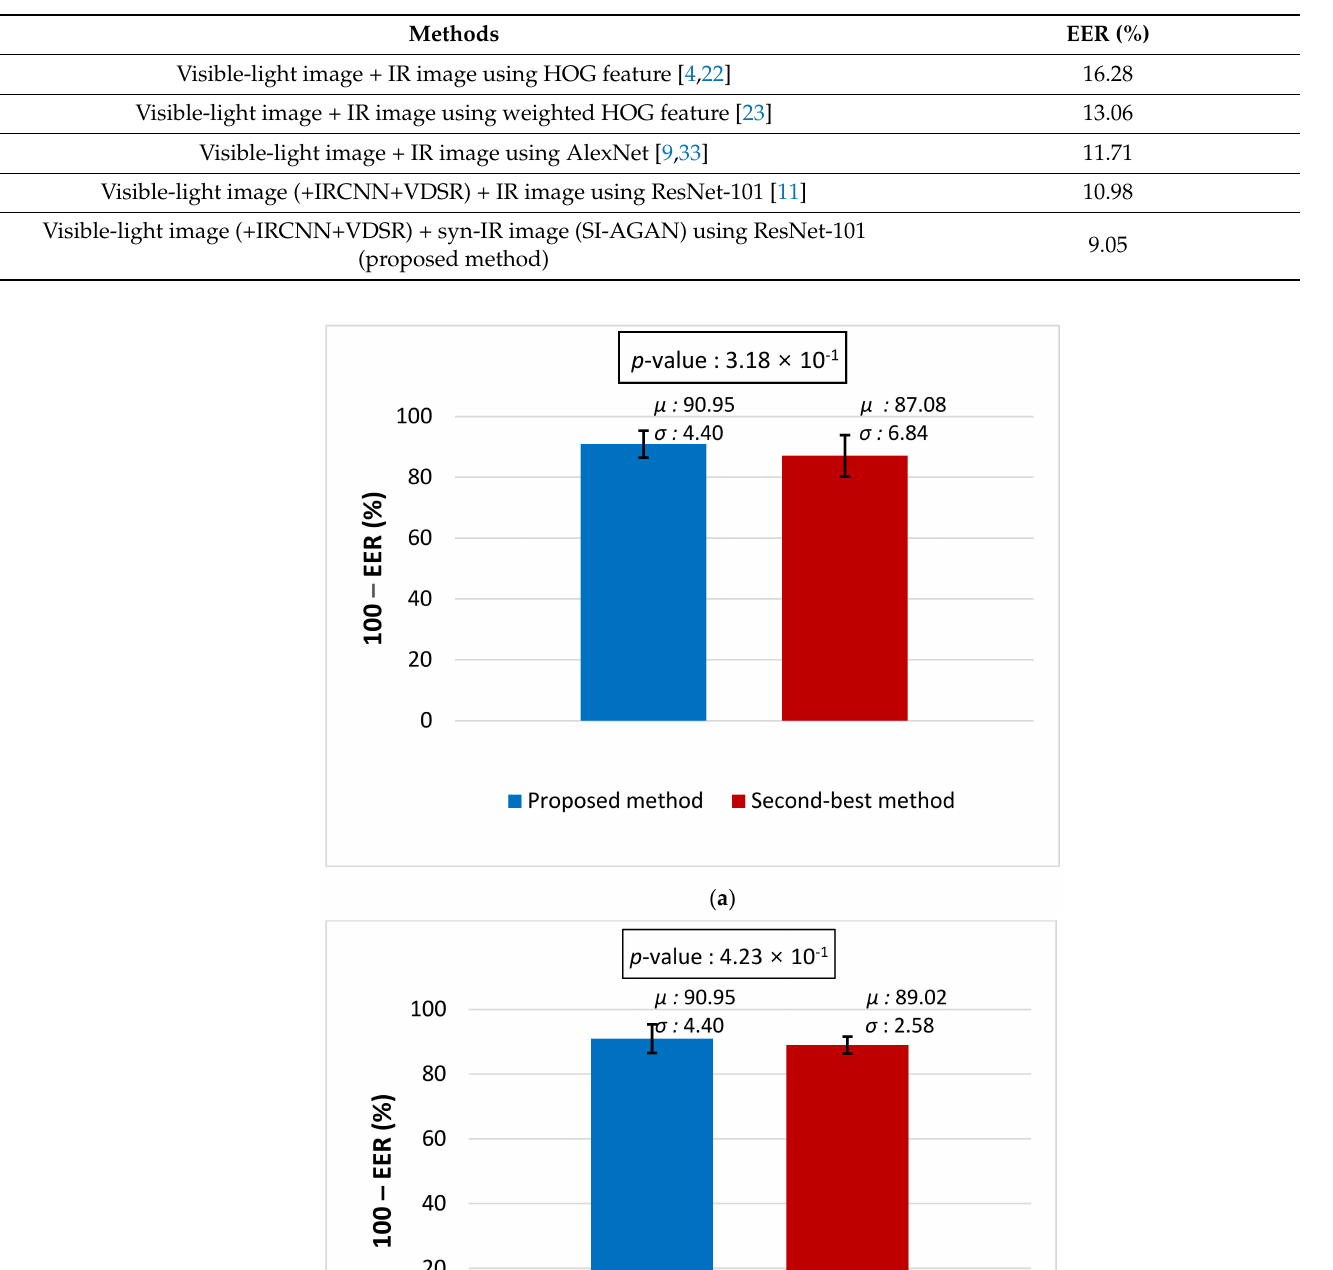
Table 12. Comparison of gender recognition accuracies with our method and previous methods.